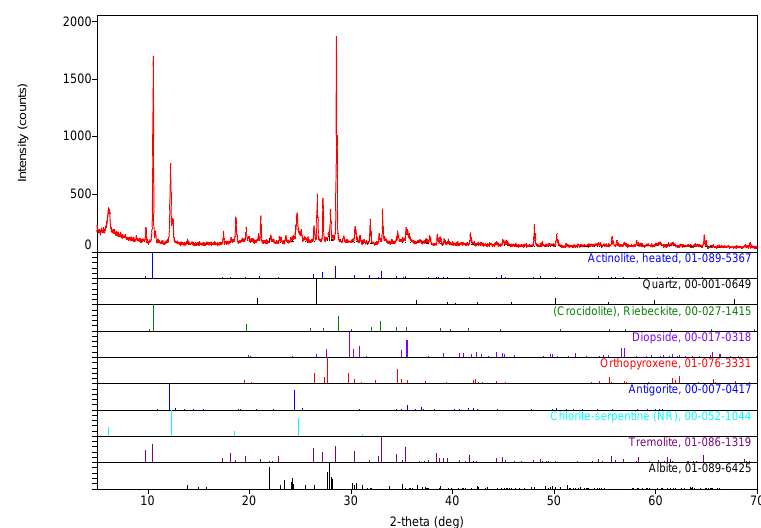
Figure A1. XRPD pattern for specimen a. XRPD patterns of indexed phases: heated actinolite (PDF# 01-089-5367), quartz (PDF# 00-001-0649), antigorite (PDF# 00-007-0417), chlorite–serpentine (NR) (PDF# 00-052-1044) and albite (PDF# 01-089-6425) are presented in the form of straight intensity lines at the bottom of the pattern.